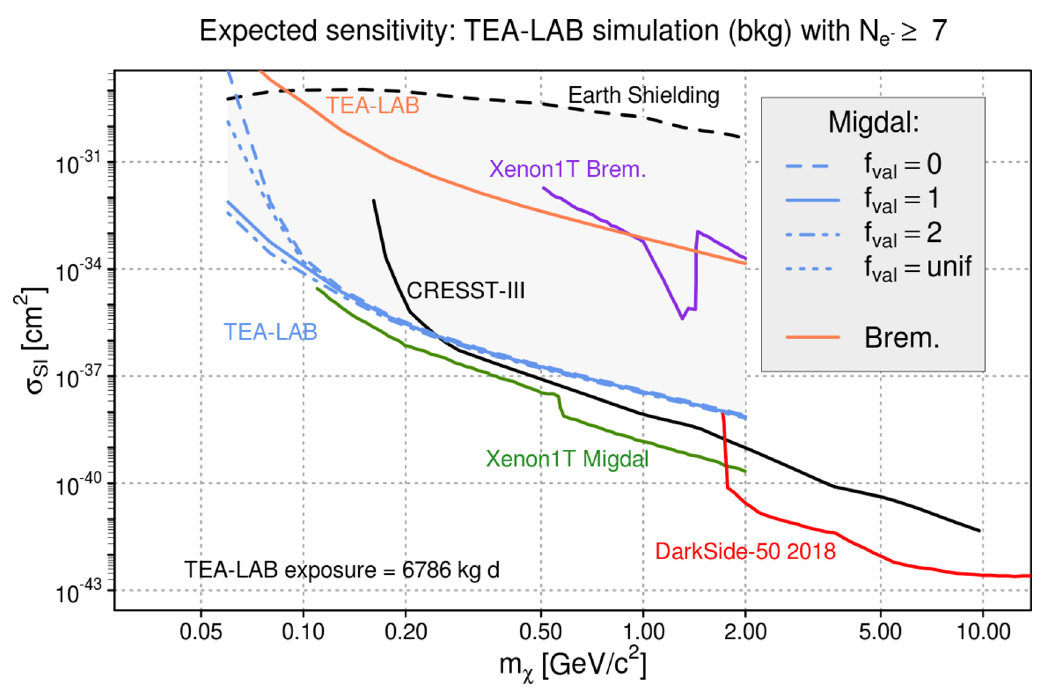
Figure 9 . 90% C : I : upper bounds on the (cid:27) SI exploiting the Migdal electron and photon Bremsstrahlung signals for the tea-lab simulated experiment loosely inspired by DarkSide-50. These results are obtained using and exposure E = 6786 kg d , and simulating a pseudo-dataset with the background-only template, not including the LowNe excess (see section 3.2, 3.1). The tea-lab bounds are computed for a threshold N = 7 . Different Migdal electron signal uncer- e (cid:0) tainties are considered (see section 3.2.2): f val = 0 corresponding to no valence shell contribution (blue dashed line), f val = 1 (blue line), f val = 2 (dashed-dotted line), and f val treated as a nuisance parameter with a uniform prior p.d.f. in [0 ; 2] (dotted blue line). The tea-lab bound for the pho- ton Bremsstrahlung signal is reported (orange line). The estimate of the Earth shielding effect for tea-lab is also reported (black dashed curve). The gray shaded area, has to be intended as the region where tea-lab has the sensitivity to exclude a DM signal exploiting the Migdal